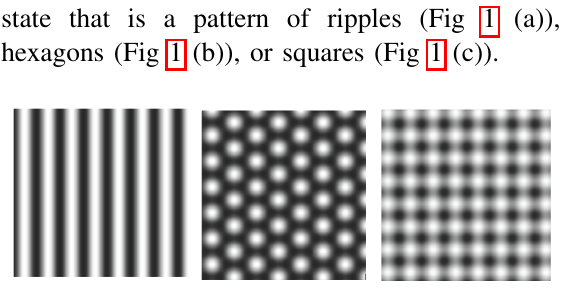
Fig. 1: Gray-scale plots of u ( x, y, t ) at time t = 10000 resulting from numerical simulations of Eq. (1). The parameter values are P = 1 . 1 , γ = 10 , and (a) β = 0 , δ = 0 , (b) β = 2 , δ = 0 , (c) β = 0 , δ = 1 . The spatial domain is − 60 ≤ x, y ≤ 60 .